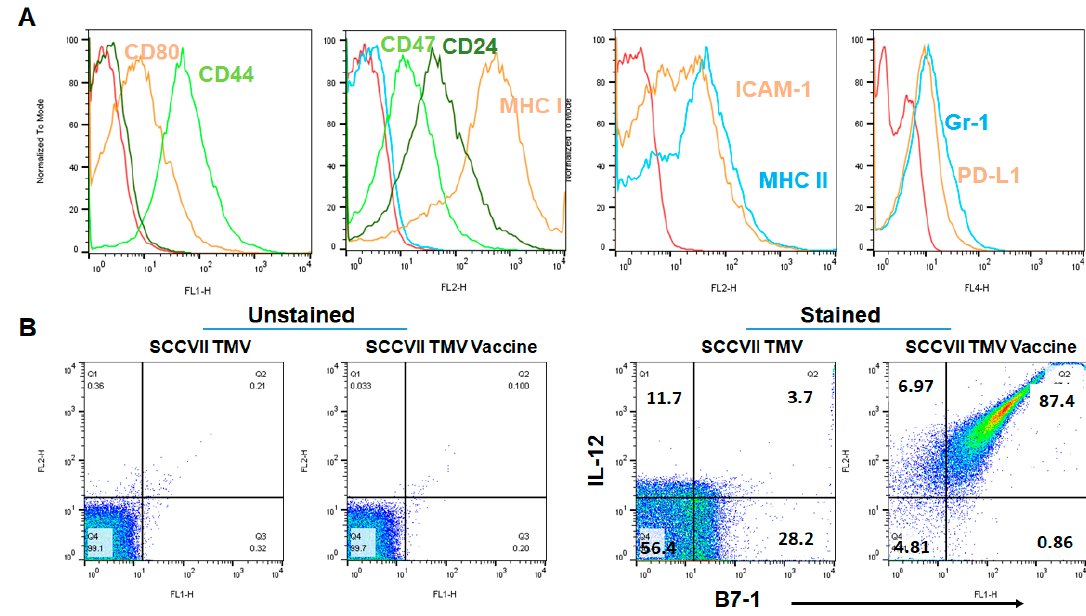
Figure 1. GPI-B7-1 and GPI-IL-12 are incorporated into tumor membrane vesicle (TMV) by protein transfer. Squamous cell carcinoma VII (SCC VII) tumors grown in C3H / HeJ mice were used to prepare TMV. TMVs were incorporated with GPI-B7-1 and GPI-IL-12 by incubating TMVs with purified mouse GPI-B7-1 and mouse GPI-IL-12 at 37 ◦ C for protein transfer as described in the Methods section. Flow cytometry analysis of markers on TMVs ( A ), and protein transferred GPI-B7-1 and GPI-IL-12 on TMV vaccine ( B ) stained with fluorochrome-conjugated antibodies after Fc receptor blocking. Isotype antibodies ( A , dark green in FL-1 panel, blue in FL-2 panel containing CD24, CD47 and MHC class I) and unstained TMV and TMV vaccine ( B ), left panels were used for gating purposes. A similar procedure was used for preparing MOC1 and MOC2 tumor TMV vaccines. Red histograms in A represent unstained TMV.